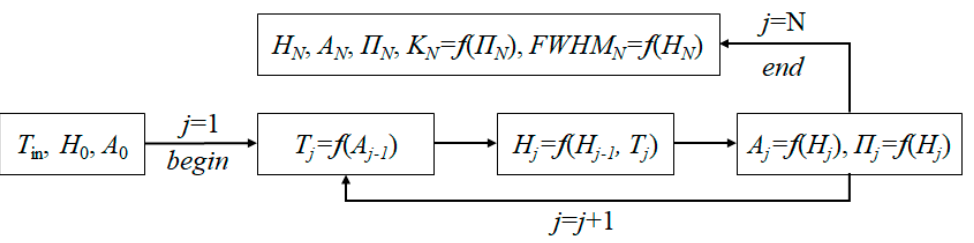
Figure 2. Block diagram of the calculation model. A 0 is an initial value of film absorption depending on an initial film thickness h ; initial oxide layer thickness H 0 = 0. T j , Π j , K j , FWHM (full width half maximum) j is the film temperature, transmittance, contrast, or element width after the action of the j -th laser pulse respectively.